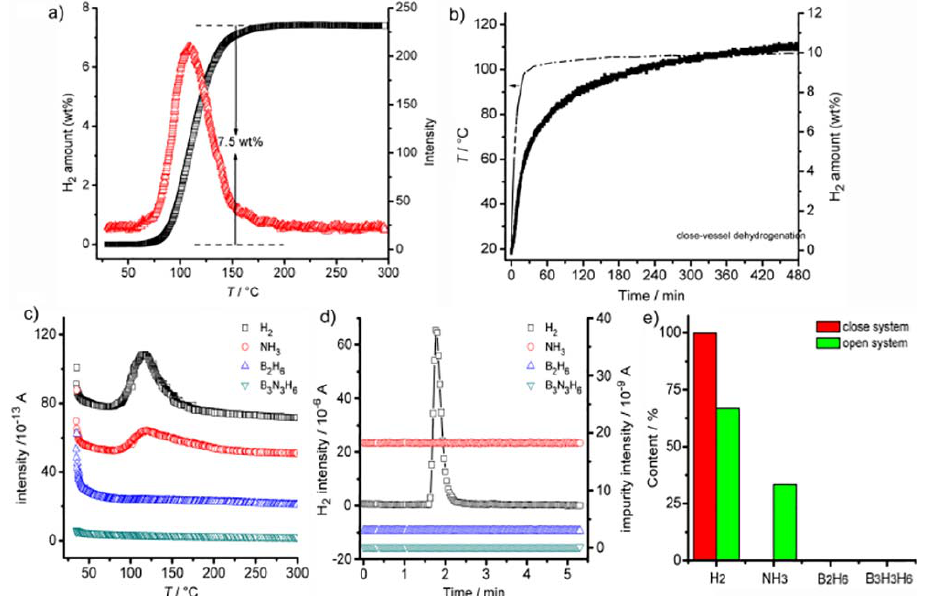
Figure 3. ( a ) TPD (  ) and gas release (  ) profiles of [Al(NH 2 BH 3 ) 63 − ][Al(NH 3 ) 63+ ] at a heating rate of 5 °C min − 1 under argon flow; ( b ) Isothermal desorption of [Al(NH 2 BH 3 ) 63 − ][Al(NH 3 ) 63+ ] in a closed vessel; the temperature ramping shown by dash dot line; ( c ) MS signals in ( a ):  H 2 ,  NH 3 ,  B 2 H 6 ,  B 3 N 3 H 6 ; ( d ) MS signals in ( b ) measured using Calibration Injection Mode:  H 2 ,  NH 3 ,  B 2 H 6 ,  B 3 N 3 H 6 ; ( e ) H 2 purity comparison between different